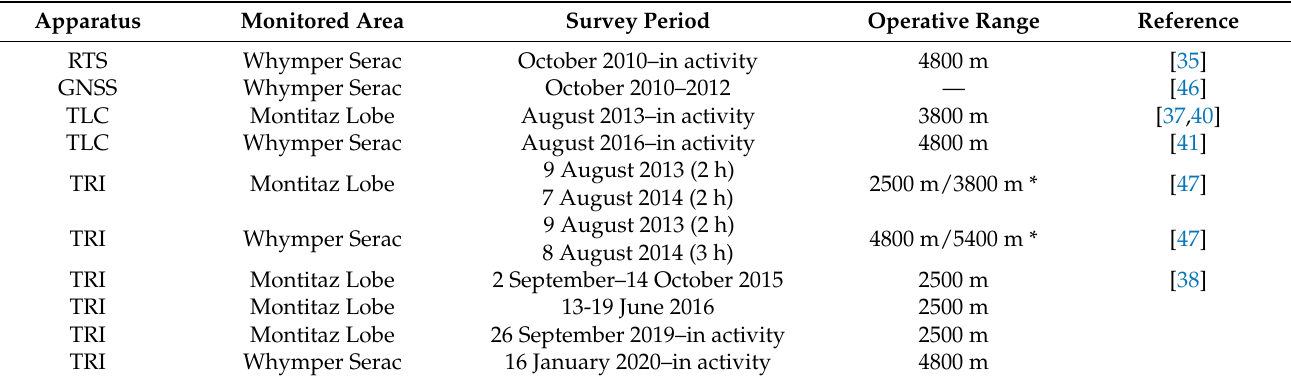
Table 1. Survey campaigns in the Grandes Jorasses glacial complex since 2010 (TLC = time-lapse camera; GNSS = global navigation satellite system; RTS = robotic total station; TRI = terrestrial radar